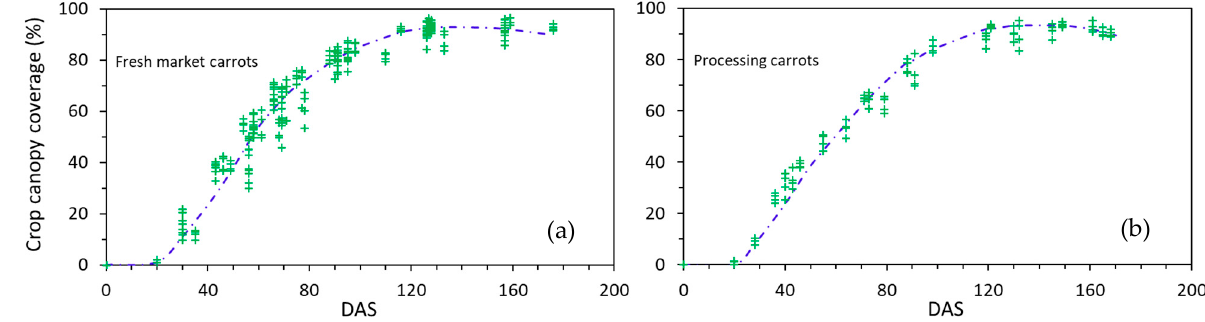
Figure 3. Canopy development curves (sigmoidal) for fresh market ( a ) and processing carrots ( b ) over the growing season. A total data set of 208 and 88 was used to develop the curves for fresh market and processing carrots, respectively. DAS stands for day after